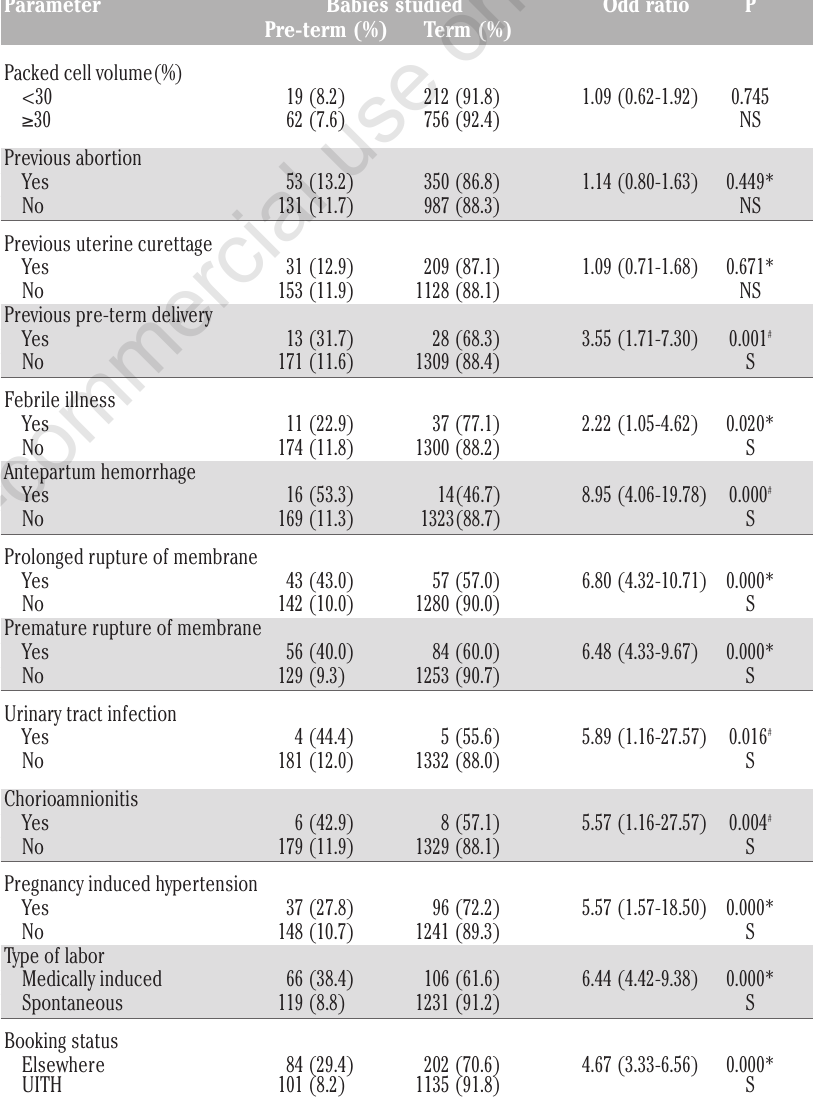
Table 2. Maternal antenatal and delivery characteristics vs pre-term delivery.